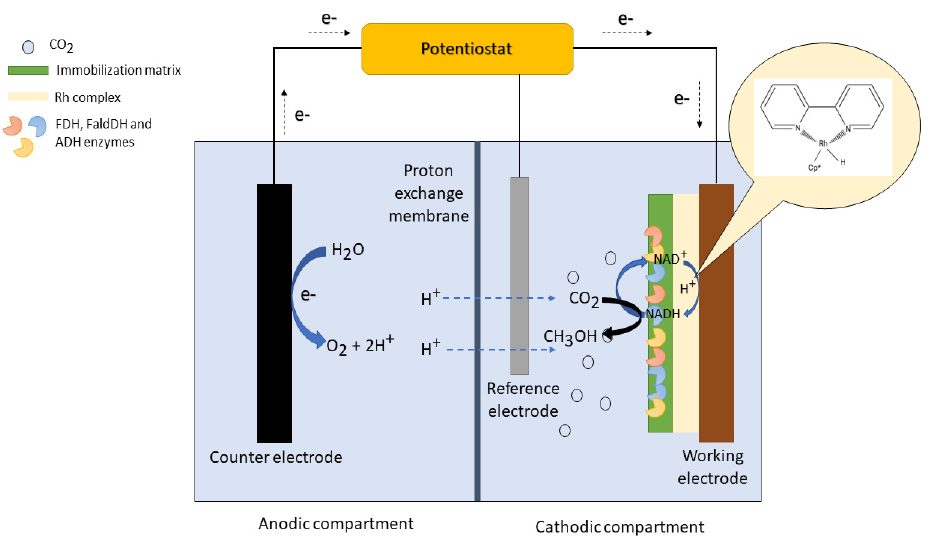
Figure 6. Schematic illustration of the general electrochemical cell design developed by researchers for catalyzing the enzymatic reduction of CO 2 , which consists of two types of compartments, namely, anodic and cathodic compartments. A Rh complex-modified working electrode was applied to prevent the production of undesired NAD 2 dimers during the electrochemical regeneration of NADH and the dehydrogenase enzymes (FDH, FaldDH, and ADH) were immobilized on an immobilization matrix electrodeposited on the working electrode.